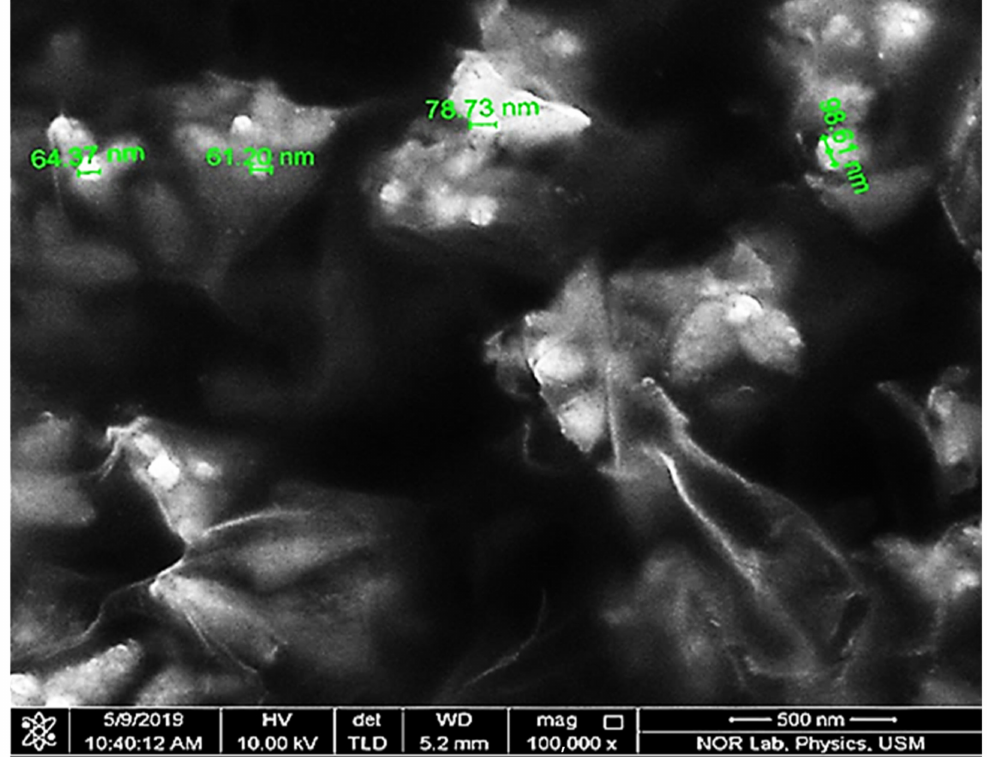
Figure 3. ZnPs FESEM